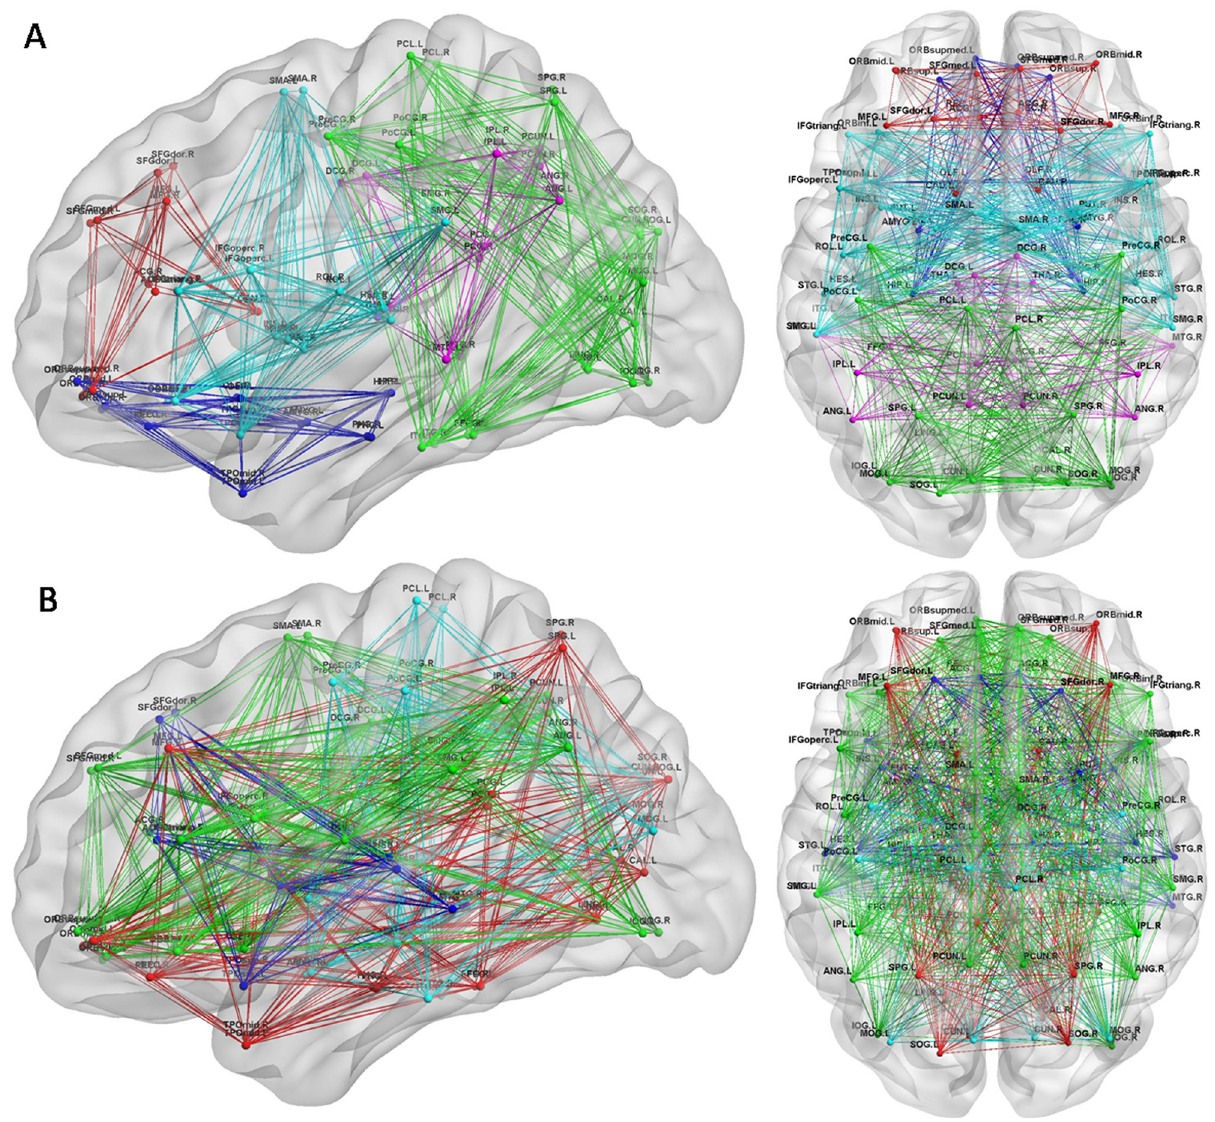
Fig 3. Modules of the functional brain networks in each group. (A) Modules of the brain network in normal controls. (B) Modules of the brain network in PD patients. Colors in nodes and links correspond to different modules. Only intramodular edges are shown. The results were visualized using the BrainNet Viewer (NKLCNL, Beijing Normal